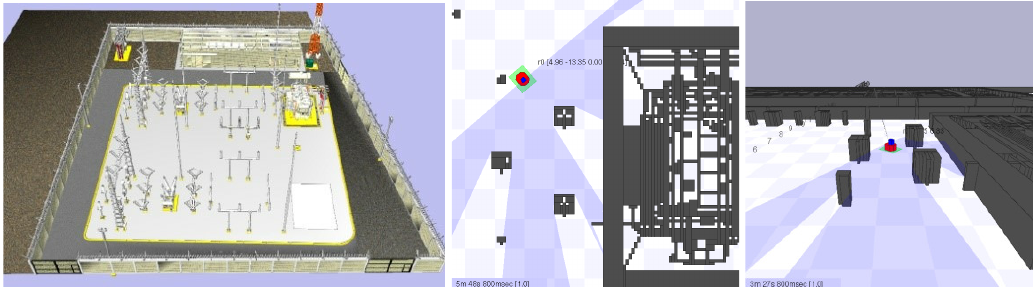
Figure 6. Virtual scaled environment. ( left ) 3D substation model. ( center ) 2D robot approaching the power transformer. ( right ) 2.5D robot approaching the power